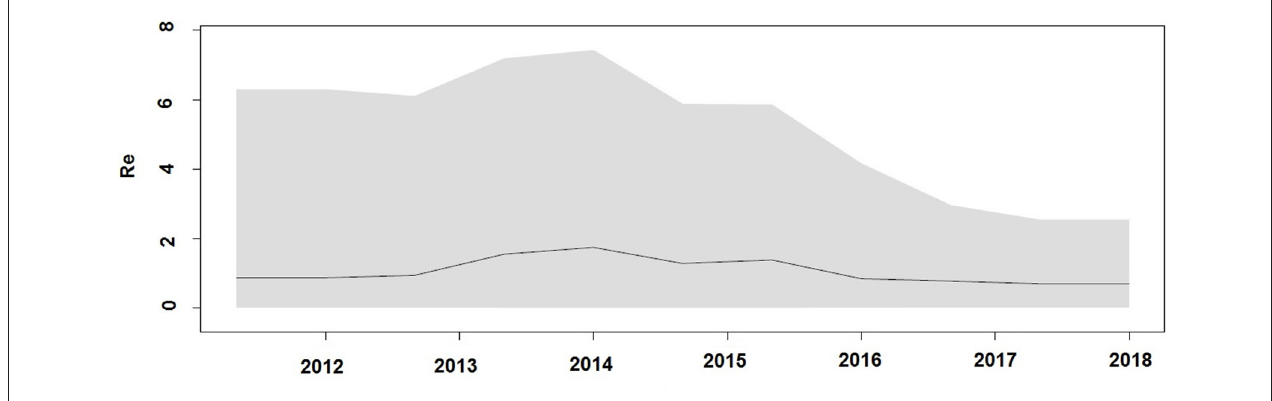
FIGURE 6 | Birth death Skyline plot derived using pol gene region demonstrating the estimates of median effective reproductive number ( R e ) over time.